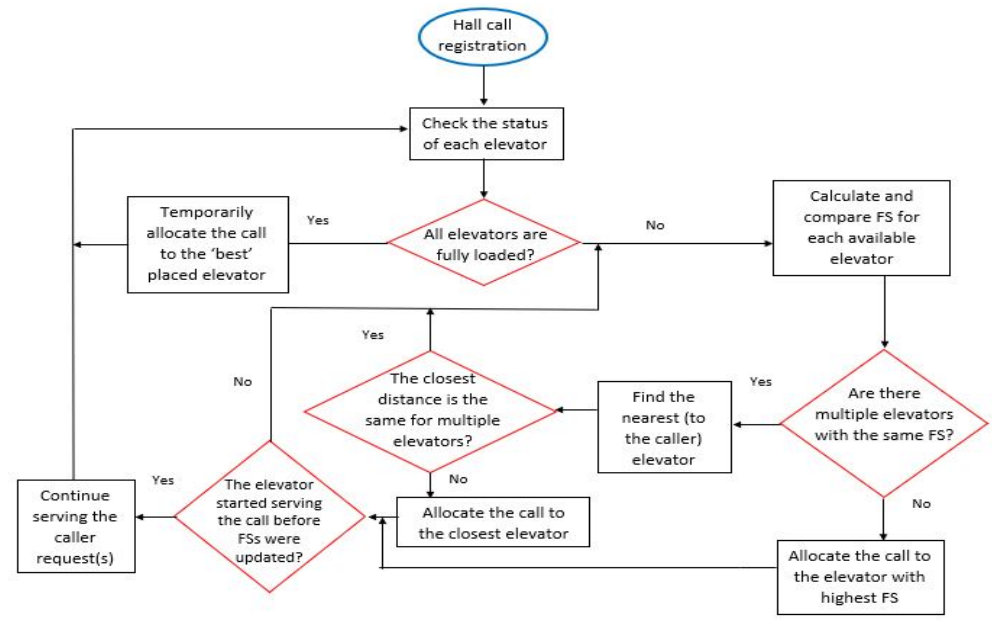
Figure 1. Flowchart of conventional nearest car (NC) algorithm.